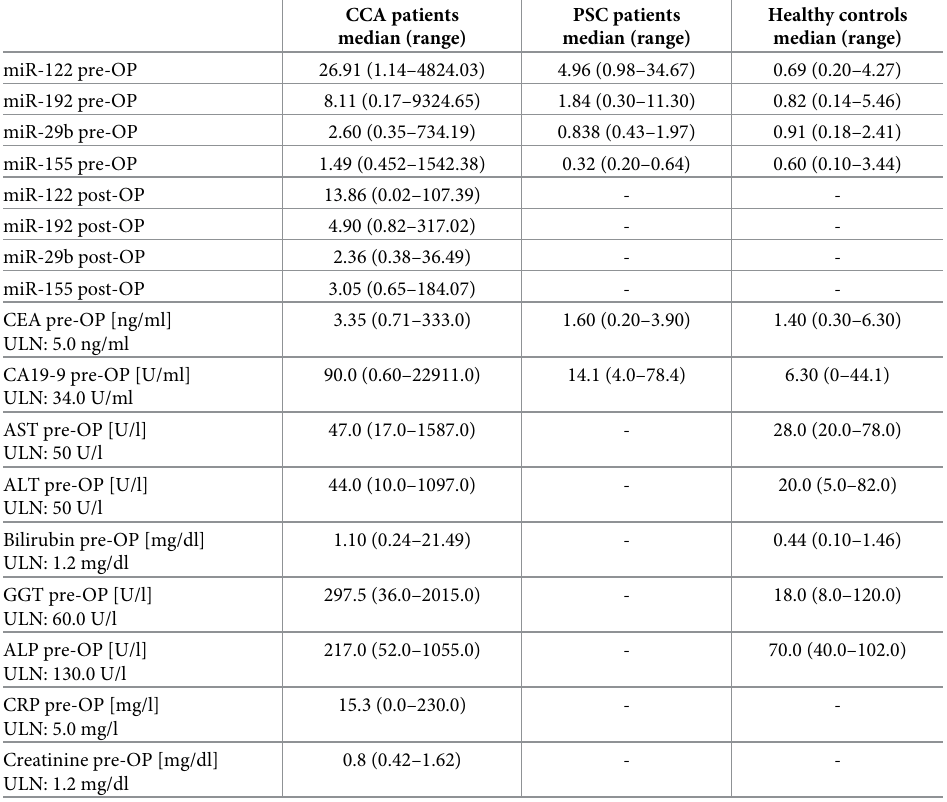
Table 2. Serum levels of the investigated miRNAs and other clinically relevant parameters.